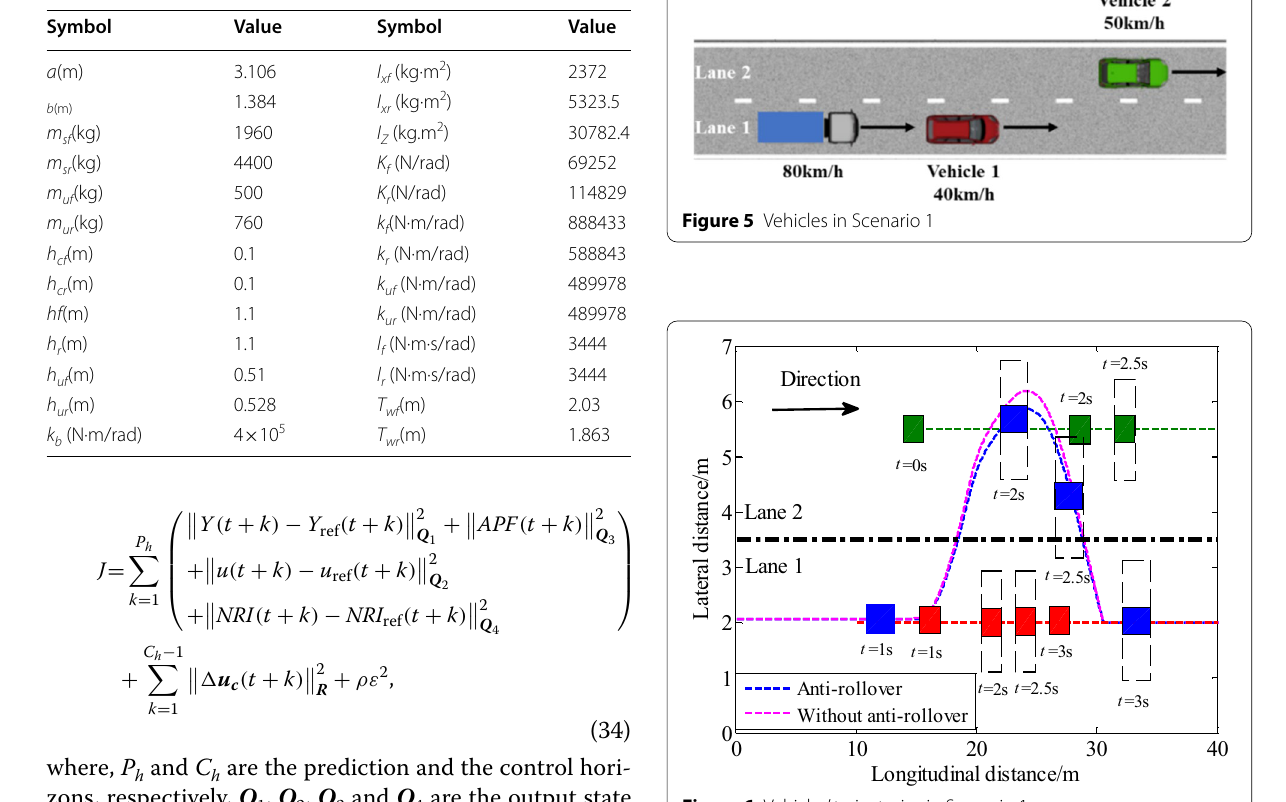
Table 1 Main parameters of the intelligent heavy truck